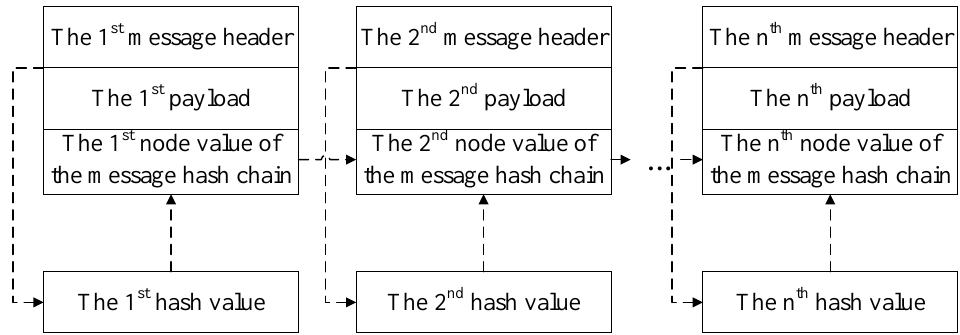
Figure 2. Schematic diagram of message hash chain